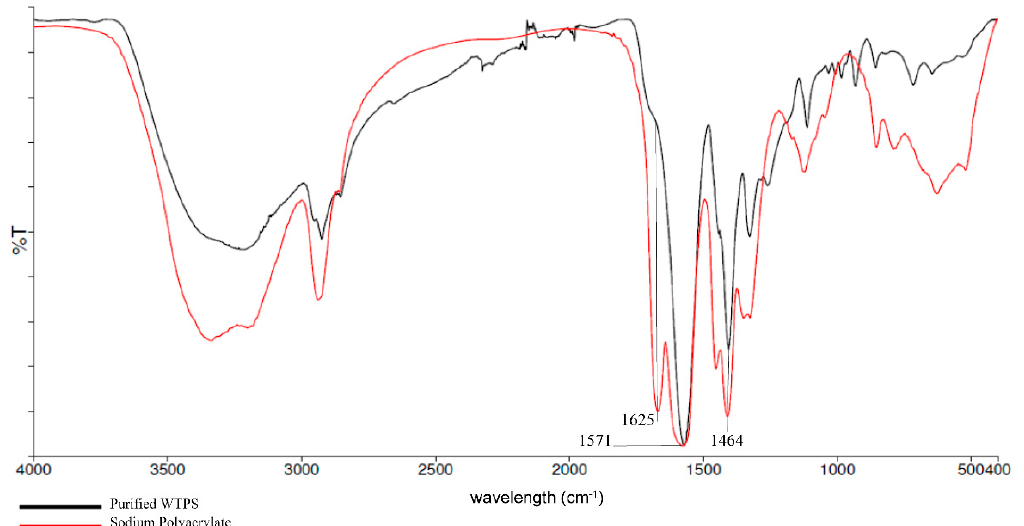
Figure 1. Fourier-transform infrared (FTIR) transmission spectra (%T) at the wavelength (cm − 1 ) of purified WTPS and sodium polyacrylate.